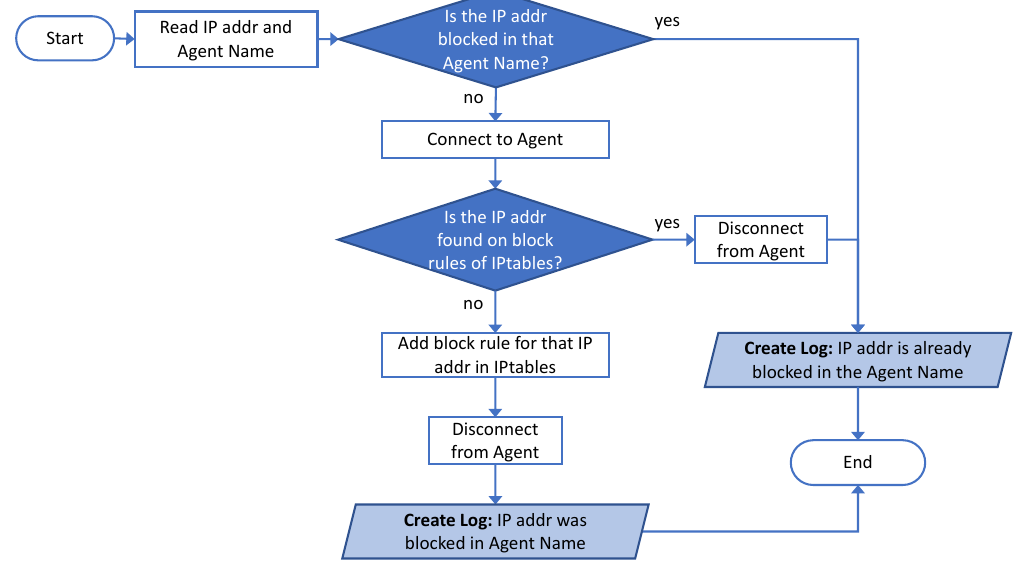
Figure 3. Procedures to block an IP address in an Agent.